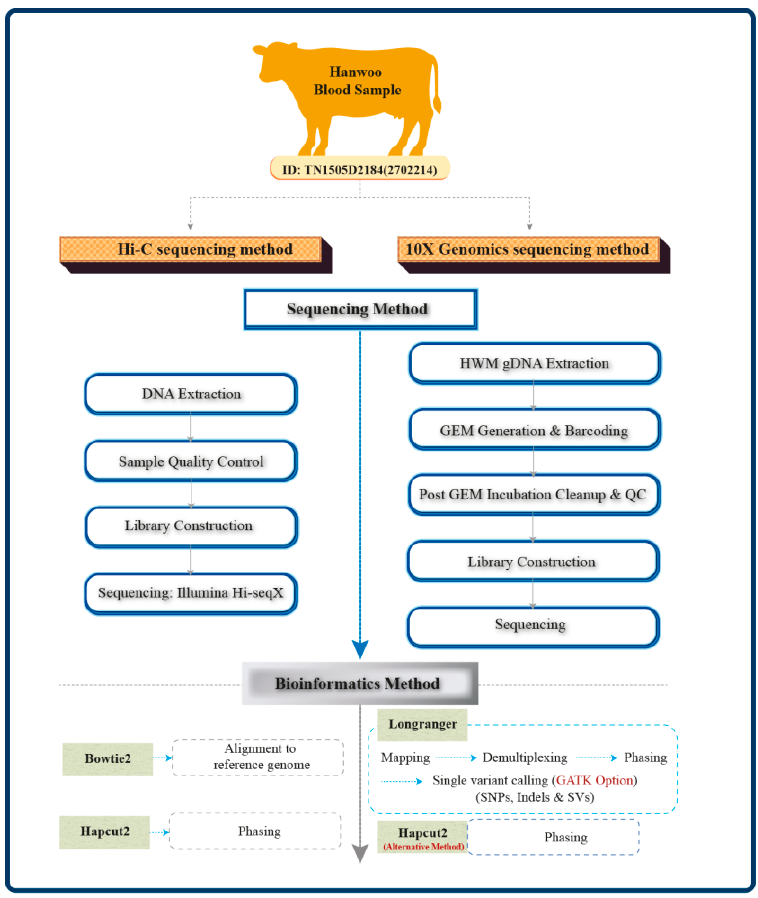
Figure 1. Schematic illustration of the two sample preparations and the three phasing approaches carried out in this study.